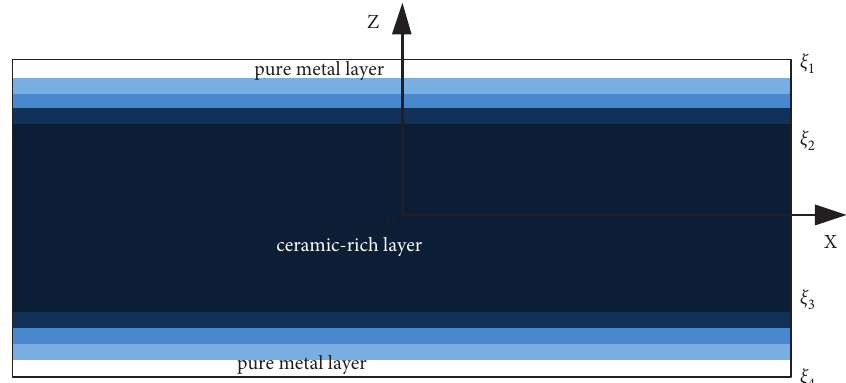
Figure 2: Type-A FGM face sheet and homogeneous honeycomb core.